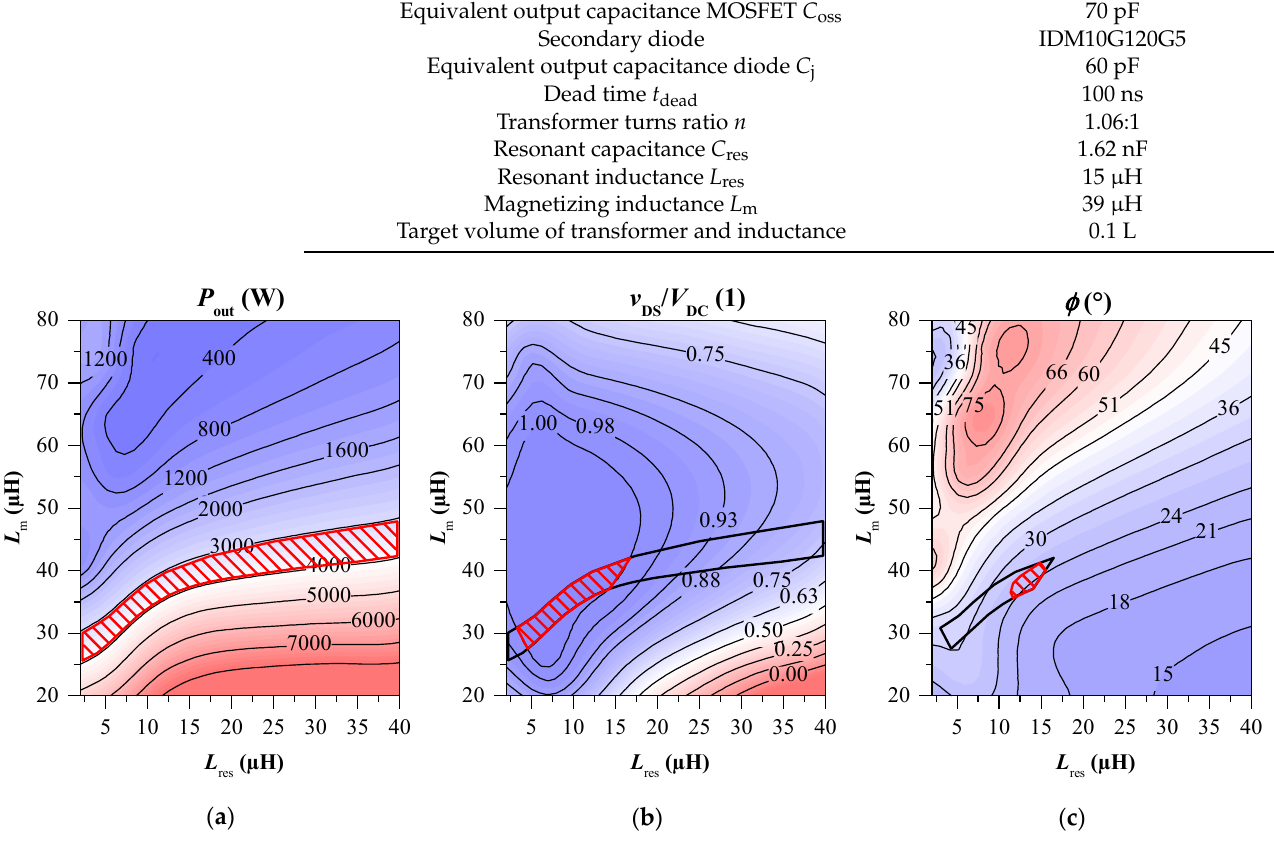
Figure 15. Parameter sweep of the magnetizing inductance L m and resonant inductance L res at f sw,LLC = 1 MHz, M = 1 using simulation. The red hatched pattern indicates the valid parameter range for ( a ) the simulated output power P out , ( b ) the ZVS condition of the primary inverter, and ( c ) the phase angle ϕ . Table 6. Specification of the LLC resonant converter.